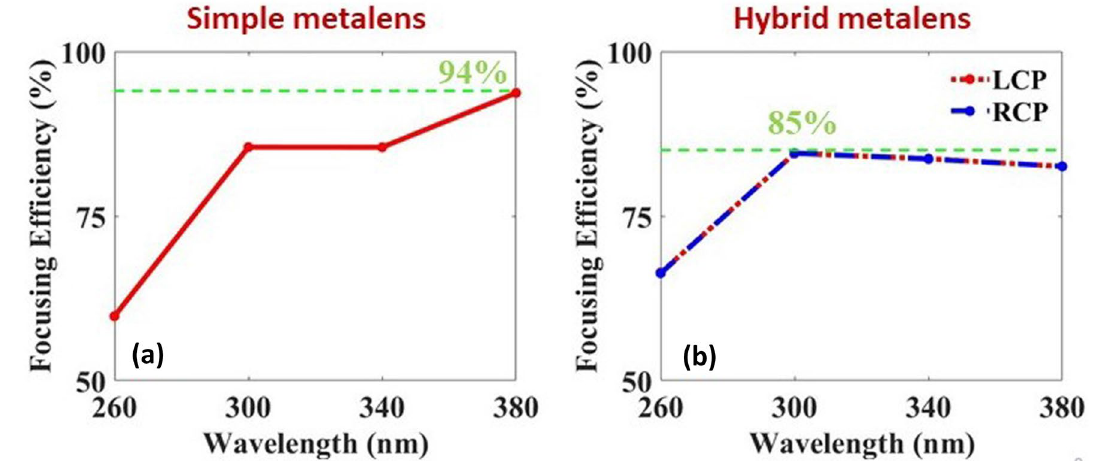
Figure 6. ( a ) Calculated focusing efficiency of the simple metalens with 20 µ m diameter for the designated wavelengths under RCP illumination, where the horizontal green dashed line shows the maximum value of the FE. ( b ) Focusing efficiency of the hybrid metalens ( R = 10 µ m) under both LCP/RCP illumination, with a maximum value of 85% shown by the dashed